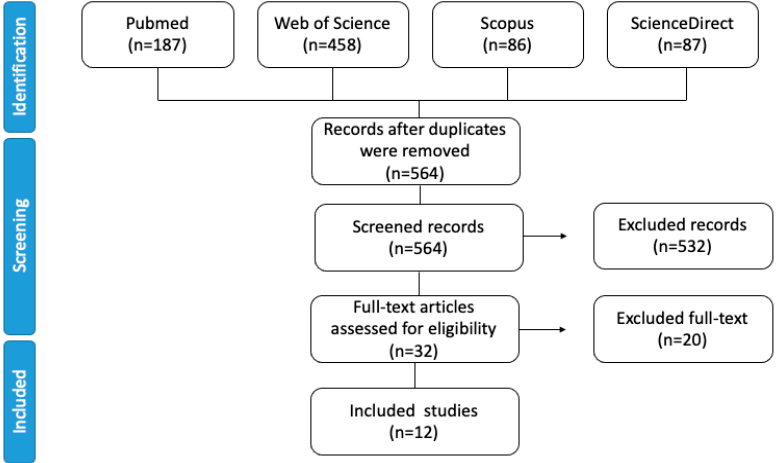
Figure 1. Flow diagram detailing the database searches, number of screened abstracts, and full texts retrieved in this systematic review. retrieved in this systematic